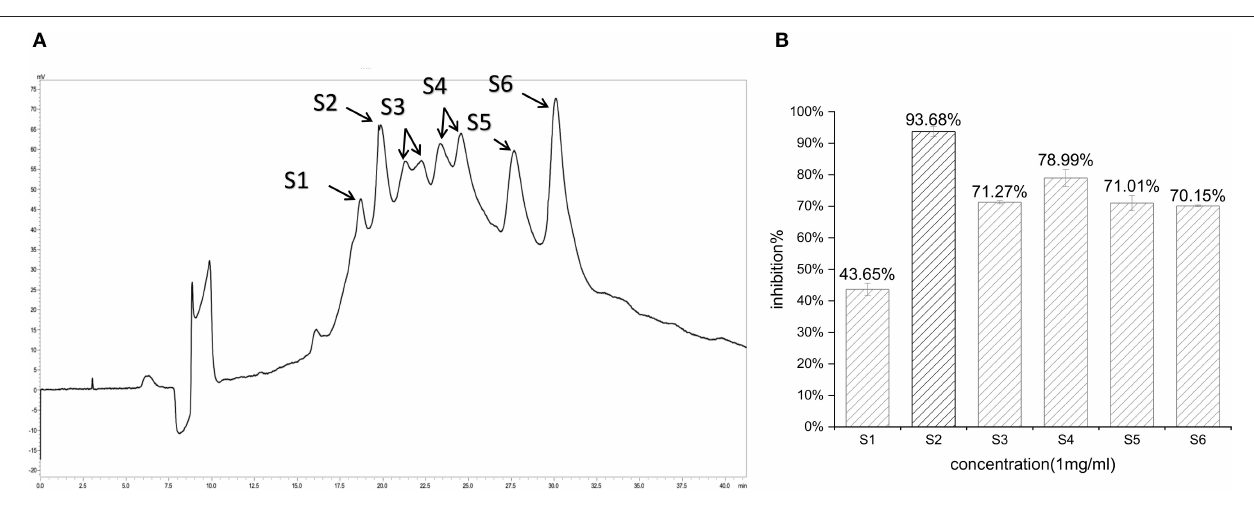
FIGURE 3 | (A) Reverse-phase HPLC chromatogram of second-step purification of the G3 fraction; (B) inhibitory activity of six pooled fractions (S1–S6).